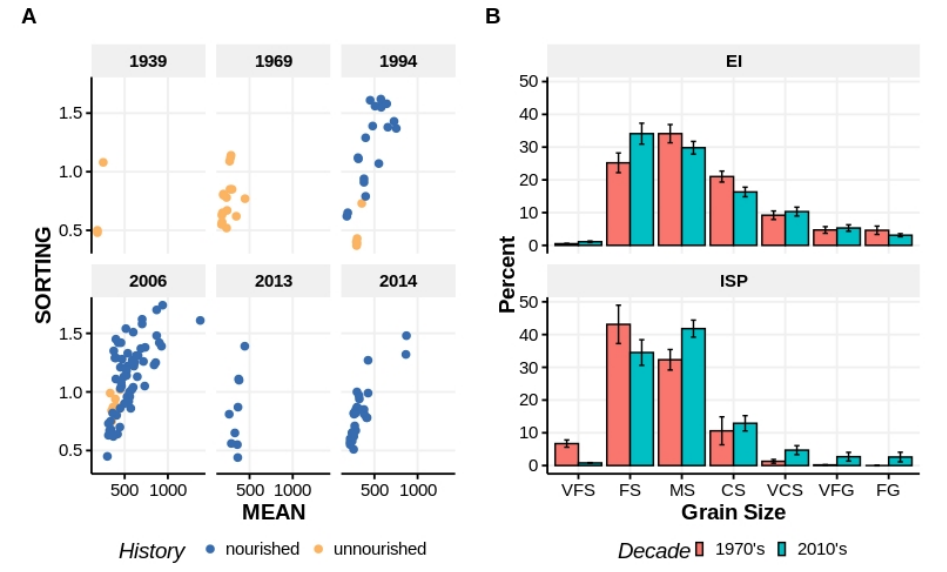
Figure 3. Comparisons of mean grain size ( µ m) versus sorting ( ϕ ) from the beach surface (0–10 cm) reported in separate studies spanning > 60 years ( A ). Teal samples were taken from beach areas that had never been nourished. Red samples were taken from beach areas that had been nourished from < 1 to > 10 years prior. Percent composition of sediment fractions for samples taken at EI and ISP in the 1970s and again, at each beach, in the 2010s ( B ). Sediment fraction codes are the same as in Figure 2.